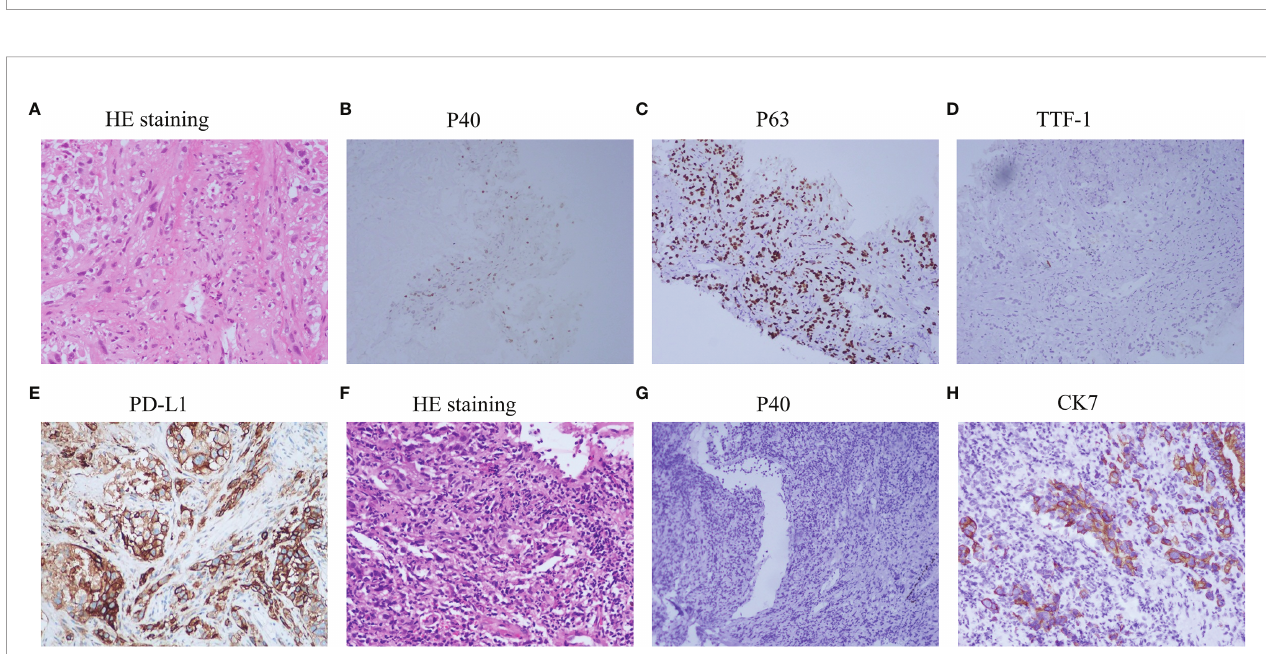
FIGURE 1 | Chest CT scanning of the patient. (A) baseline; (B) after one cycle of neoadjuvant immuno-chemotherapy (albumin-bound paclitaxel + carboplatin + nivolumab 240 mg); (C – F) chest images at indicated time points.